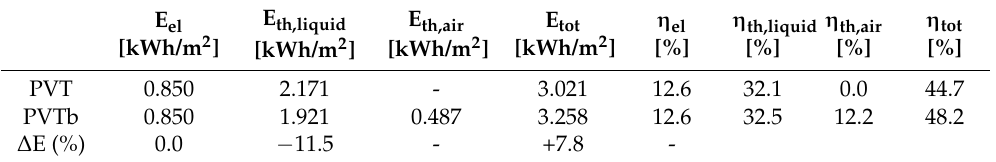
Table 4. Energy yields of conventional water-based (PV/T) and bi-fluid collector (PVTb).